Question: Write the caption for this figure.
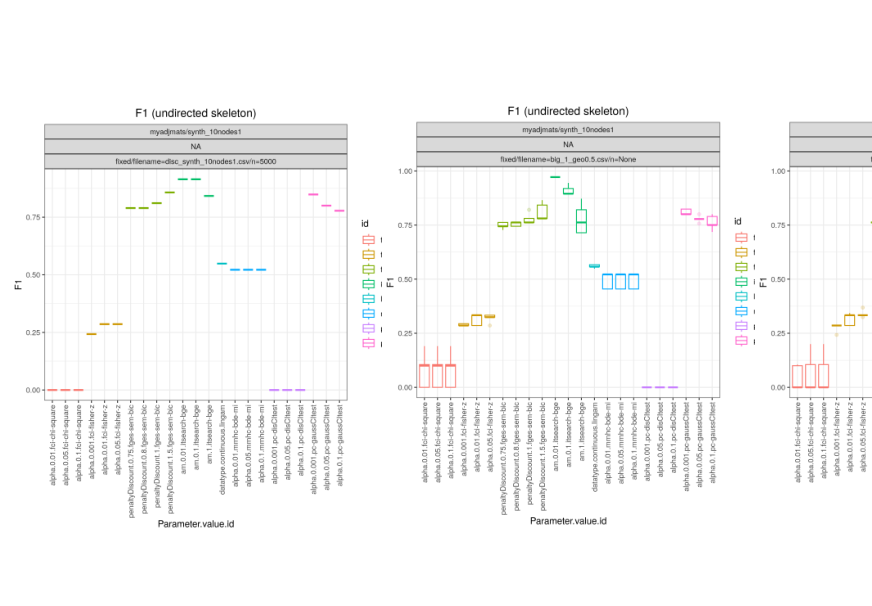
Answer: F1 Scores on the Synthetic 10 nodes data set. Discretized, no noise.